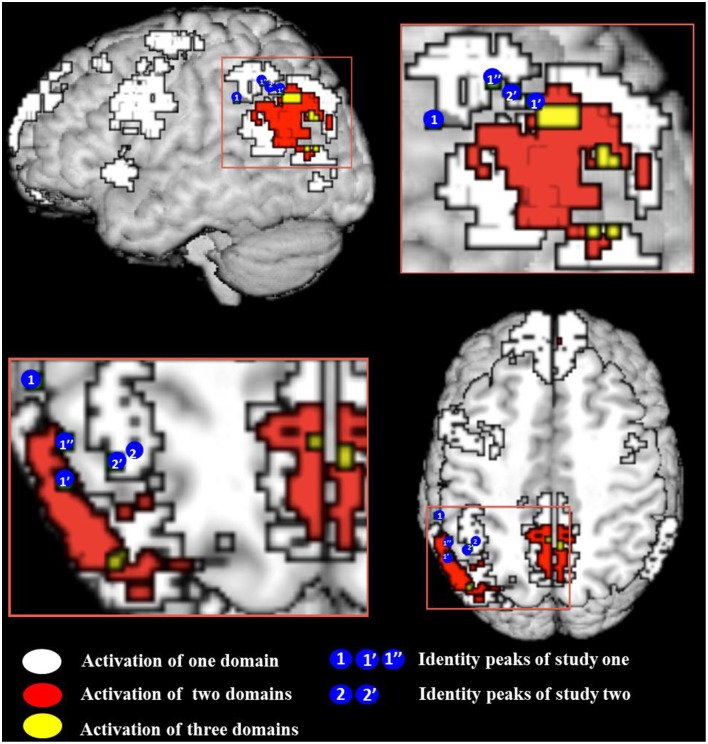
Conjunction map of all meta-analyses false belief (FB), episodic memory (EM), and visual perspective taking (vPT). White indicates the regions activated by one meta-analysis, red and yellow indicate the conjunction of at least two and three meta-analyses. Location of activation peaks for the identity contrast are shown as blue circles with the number of the study—see Table 4 for peak coordinates and overlap details (areas of the blue circles do not reflect the actual size of the activation). All meta-analytic maps were thresholded at voxel-wise threshold of p < 0.005 uncorrected and a cluster extent threshold of 10 voxels. Activations of all meta-analyses are superimposed on the Talairach template.